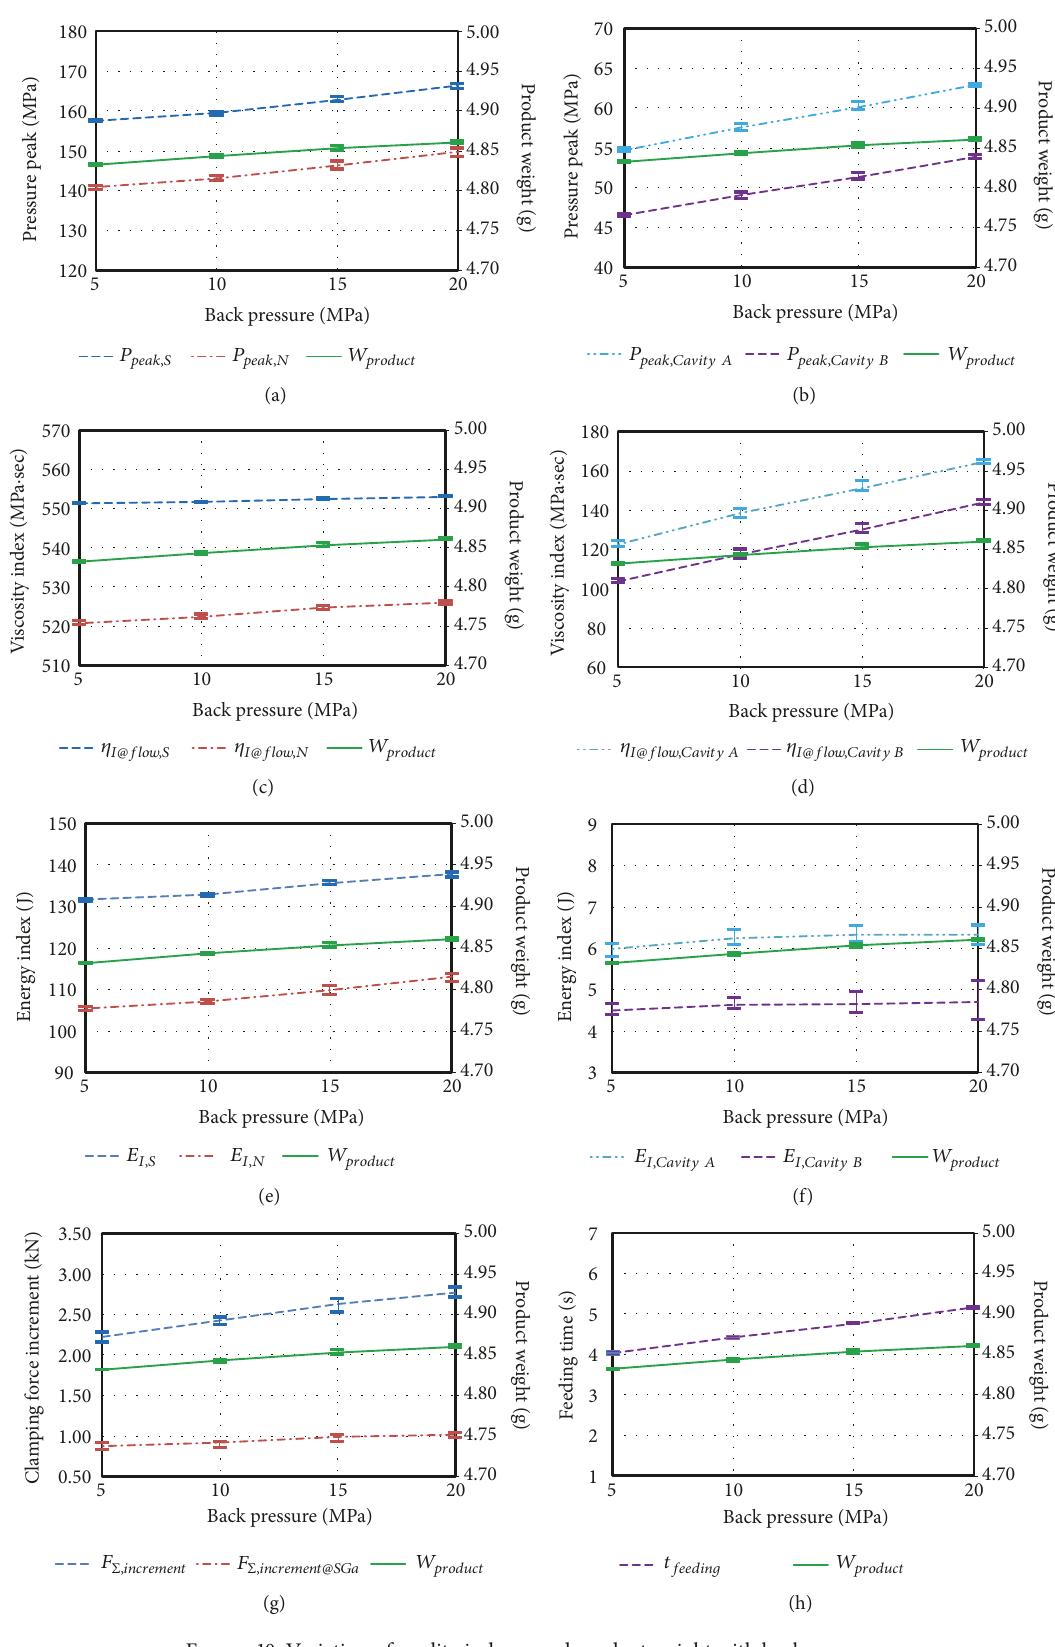
Figure 10: Variation of quality indexes and product weight with back